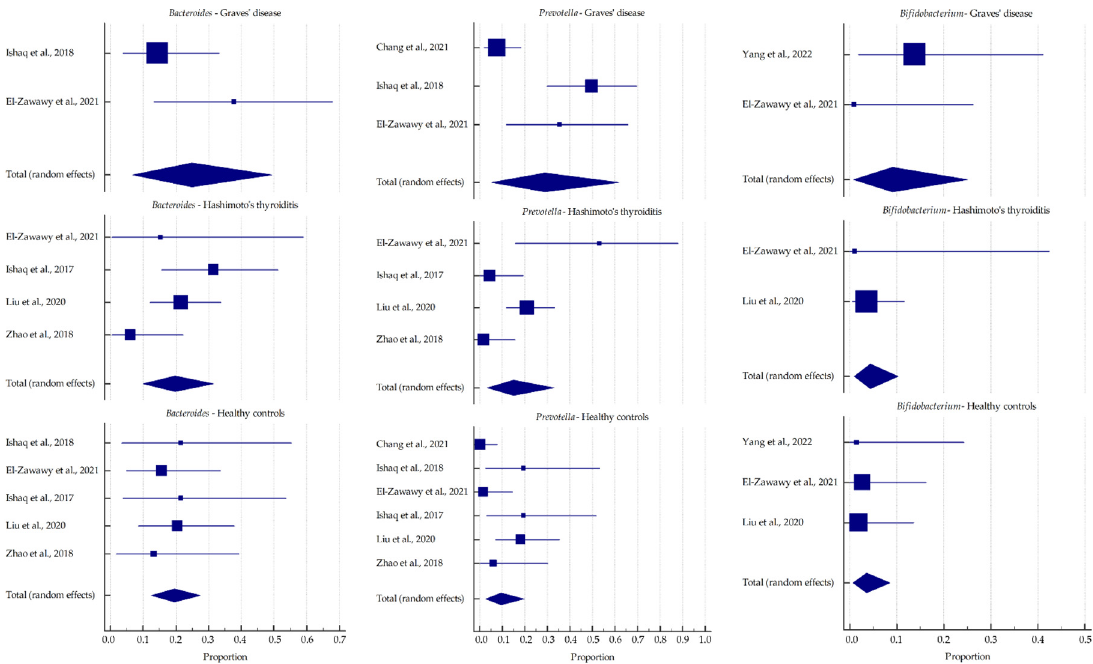
Figure 6. Forest plots representing the pooled relative abundance for the most common genera in the included studies [30,32,38,41,43–45] .